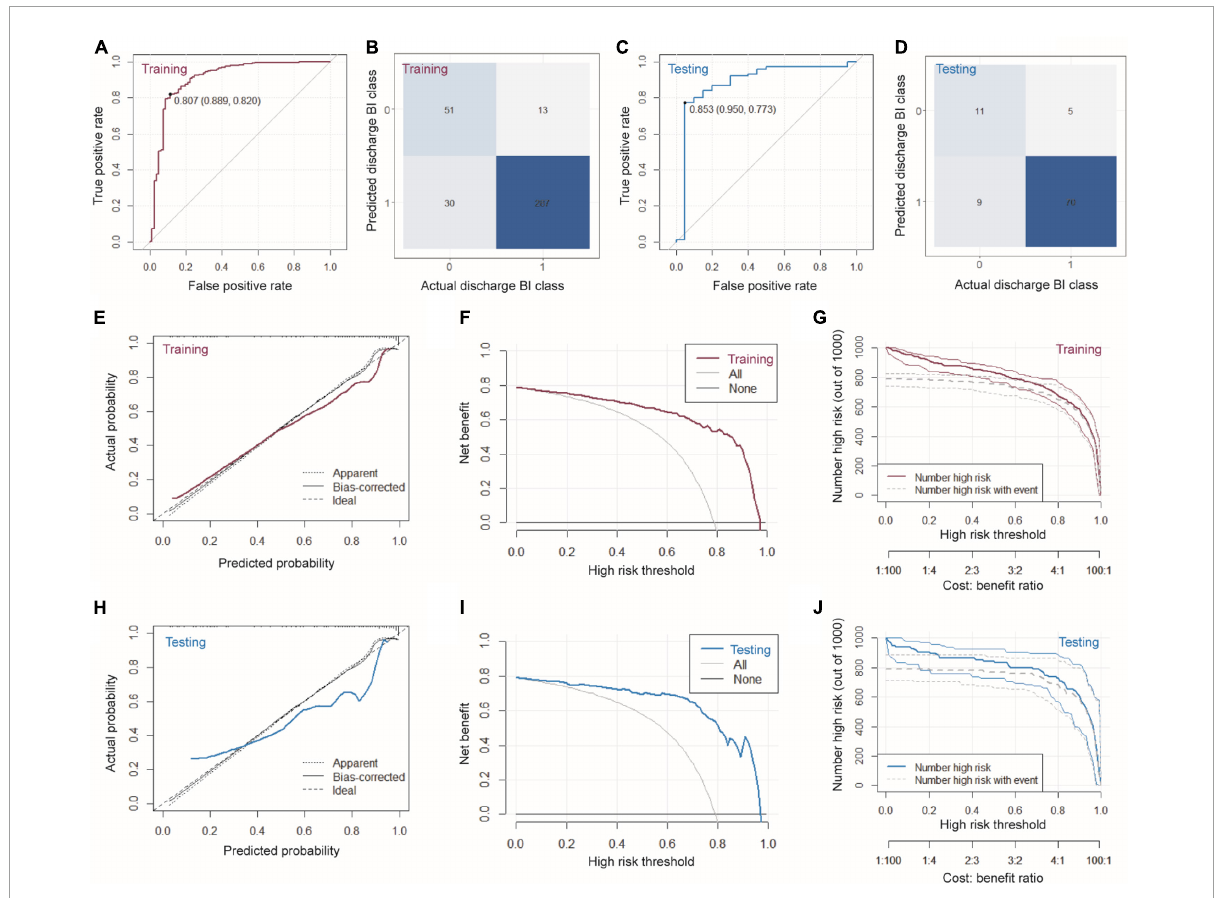
FIGURE3 Characterizations of the nomogram model. (A) ROC, (B) confusion matrix, (E) calibration curve, (F) decision curve, and (G) clinical impact curve of the model on the training dataset. (C) ROC, (D) confusion matrix, (H) calibration curve, (I) decision curve, and (J) clinical impact curve of the model on the testing dataset.